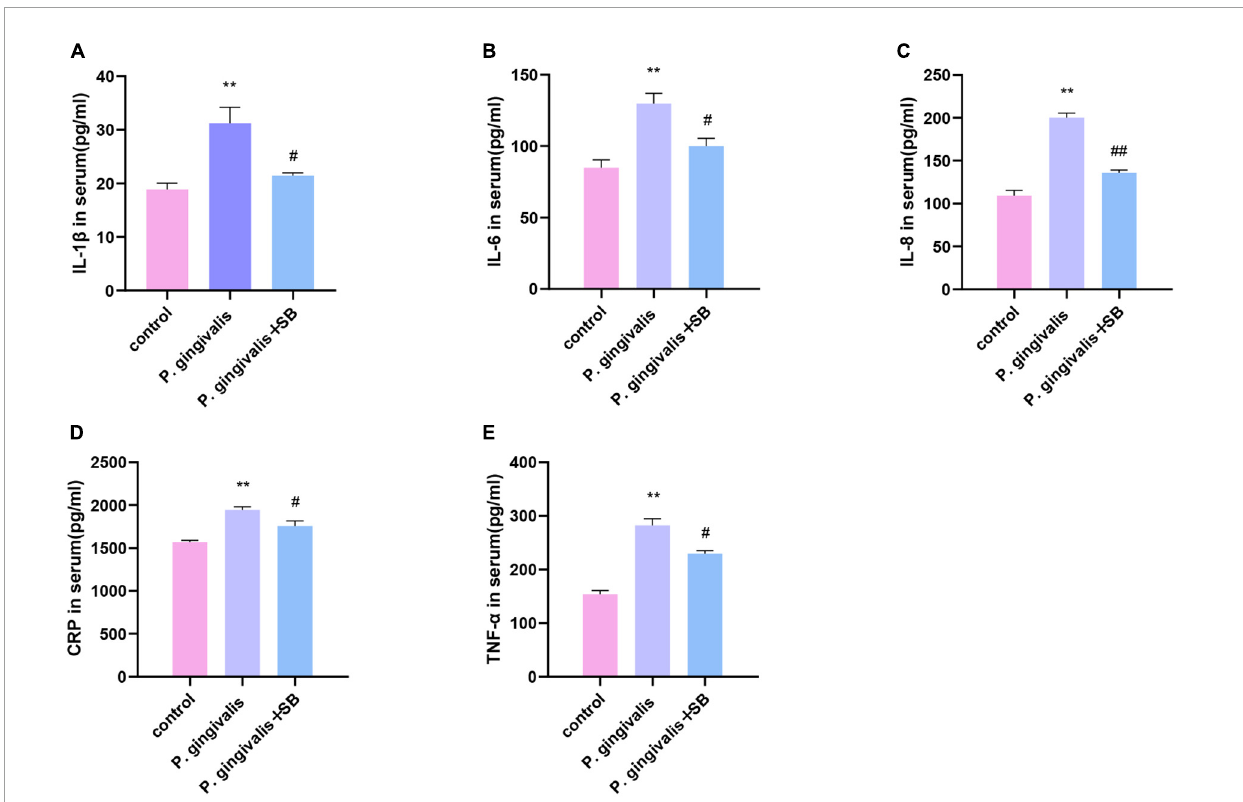
FIGURE6 Effects of periodontal inflammation in the serum. ELISAs were performed to detect the protein levels of inflammatory cytokines. (A) IL-1 β ; (B) IL-6; (C) IL-8; (D) CRP; (E) TNF- α . Experimental values are expressed as the mean ± SEM ( n = 4 per group). ** p < 0.01 compared with the control group, # p < 0.05 and ## p < 0.01 compared with the P. gingivalis